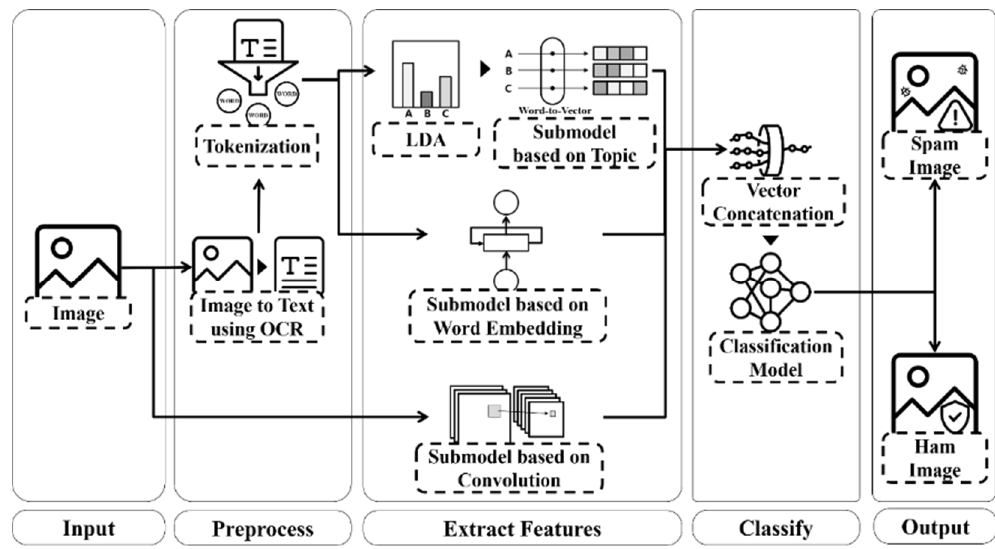
Figure 1. Overall